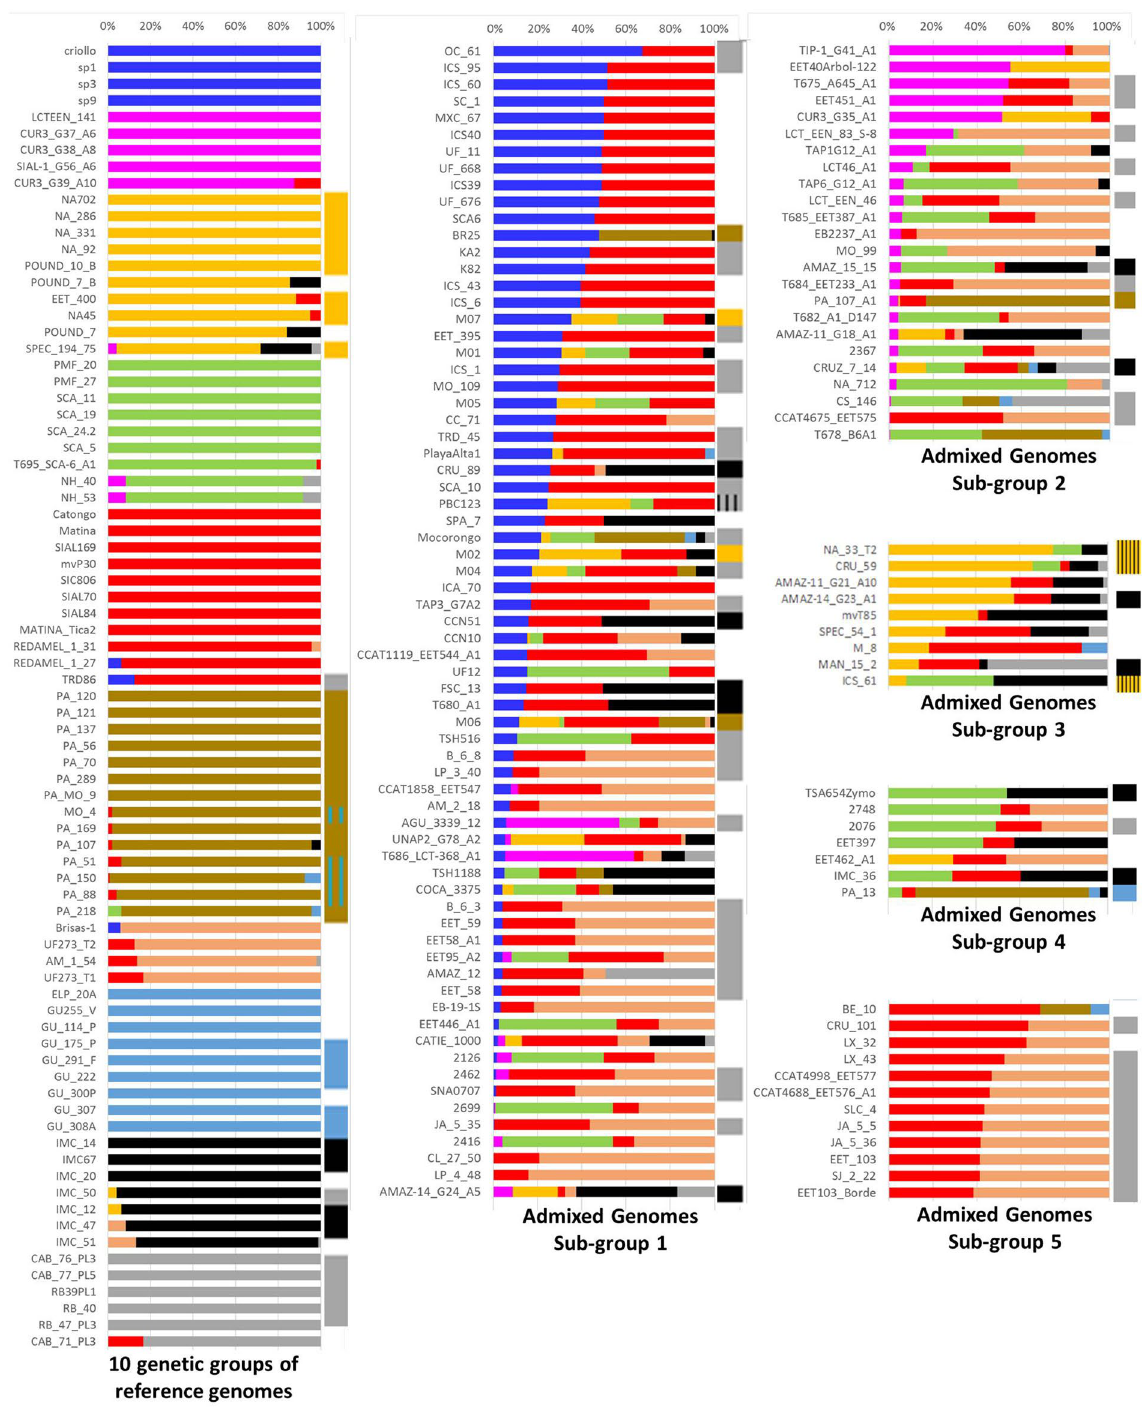
Figure 3. Summary of the bioinformatic search for the presence of the different types of viral sequences in cacao genomes. Bar graph representing population structure in cacao, redrawn from a previous study 20 . The first block on the left side represents 79 clones (with names) grouped into ten distinct genetic groups. The other two blocks represent 121 admixed clones grouped into five sub-groups based on shared proportion of ancestry (horizontal bars). The narrow column on the right side of the individual horizontal bars represents the type of viral sequence found in the clones positive for the viral mapping. The colours correspond to the following groups/ virus types : Blue (Criollo), Magenta (Curaray), Golden (Nanay/ III ), Green (Contamana), Red (Amelonado), Dark brown (Marañon/ II ) , Light brown (Nacional), Light blue (Guiana/ I ), Black (Iquitos/ V) and Grey (Purús/ VI ). Boxes with hatching patterns represent two viral